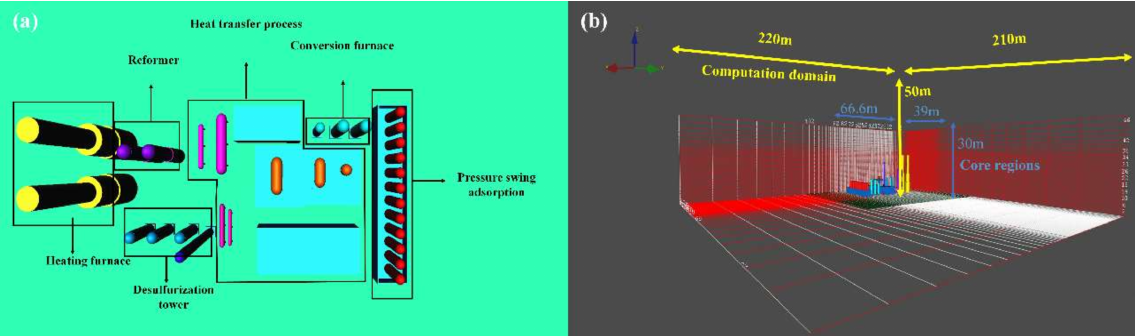
Figure 1. Numerical model of the reforming equipment. ( a ) side view including the main equipment in SMR process illustrated in the picture ( b ) top view showing the grid parameters of computation domain region and the core